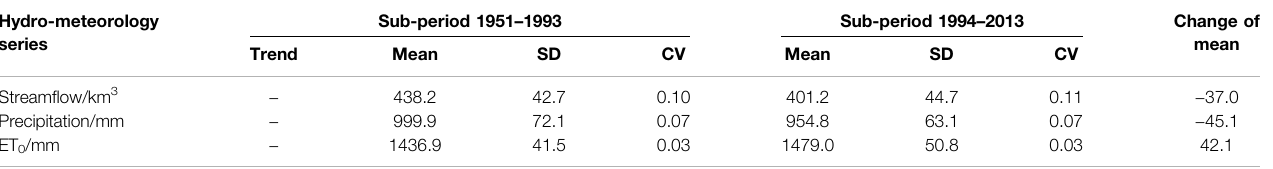
TABLE 1 | Characteristics ofthe stream fl ow, precipitation and ET 0 series in the UYRB before and after change point (Note: – representsa con fi dence level lower than 80%). Hydro-meteorology series